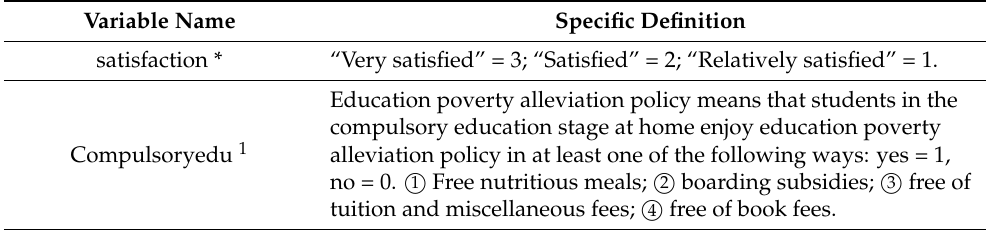
Table 3. Definition of the main